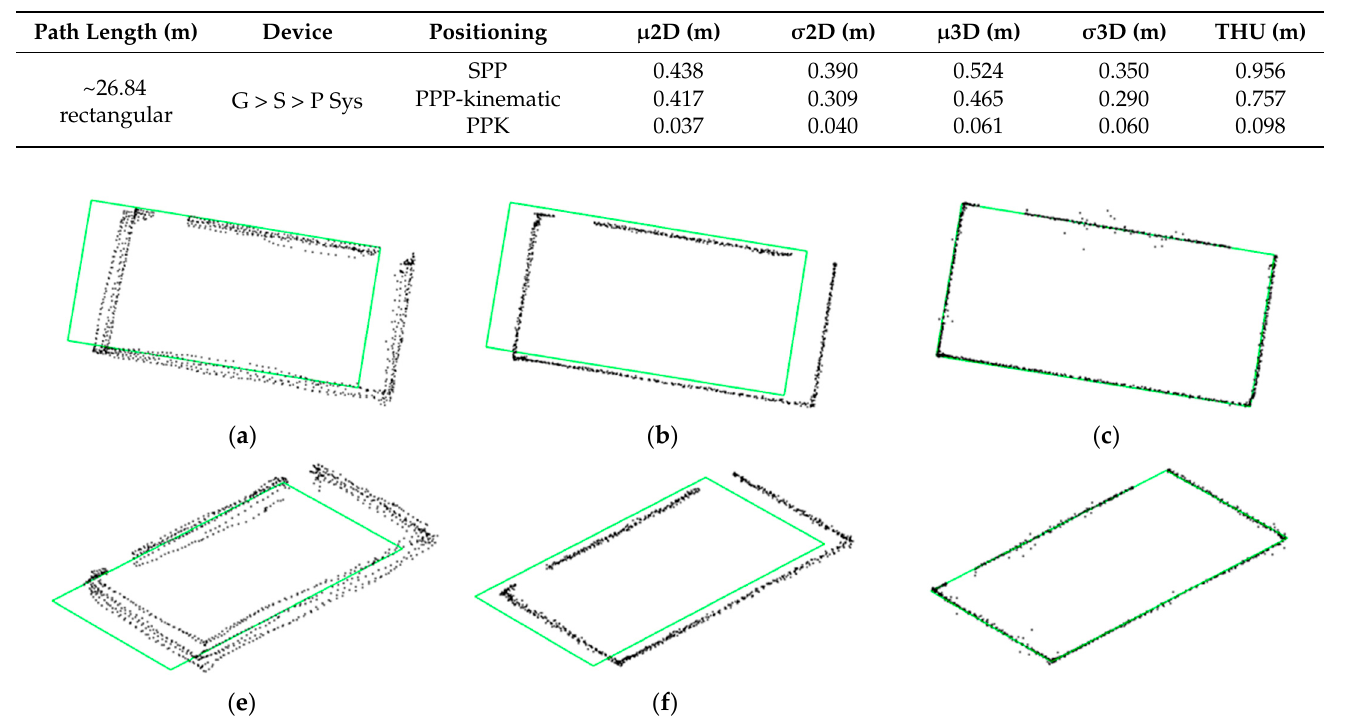
Figure 14. Comparison of the GNSS kinematic positioning of the G > S > P Sys in the pool test: ( a ) planimetric SPP; ( b ) planimetric PPP-kinematic positioning; ( c ) planimetric PPK positioning; ( d ) 3D€P; ( e ) 3D PPP-kinematic positioning, ( f ) 3D PPK